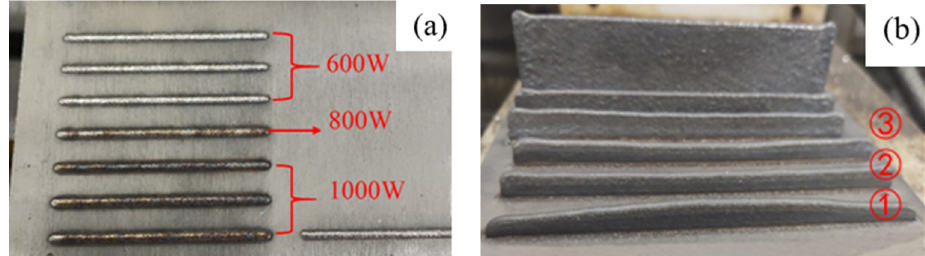
Figure 3. Single-pass cladding layer forming experiment: ( a ) single-layer; ( b )